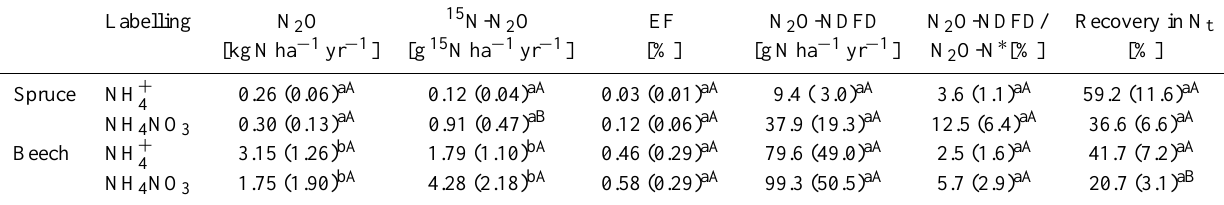
Table 3. Cumulative N 2 O and 15 N-N 2 O emissions, one-year emission factor (EF), N 2 O derived from deposition (N 2 O-NDFD), ratio of N 2 O-NDFD to total N 2 O emissions, and recovery of 15 N tracer in N t of the organic layer and the upper 10cm of mineral soil. Results are derived from the NH + -labelled and NH 4 NO 3 -labelled treatments of the one-year 4